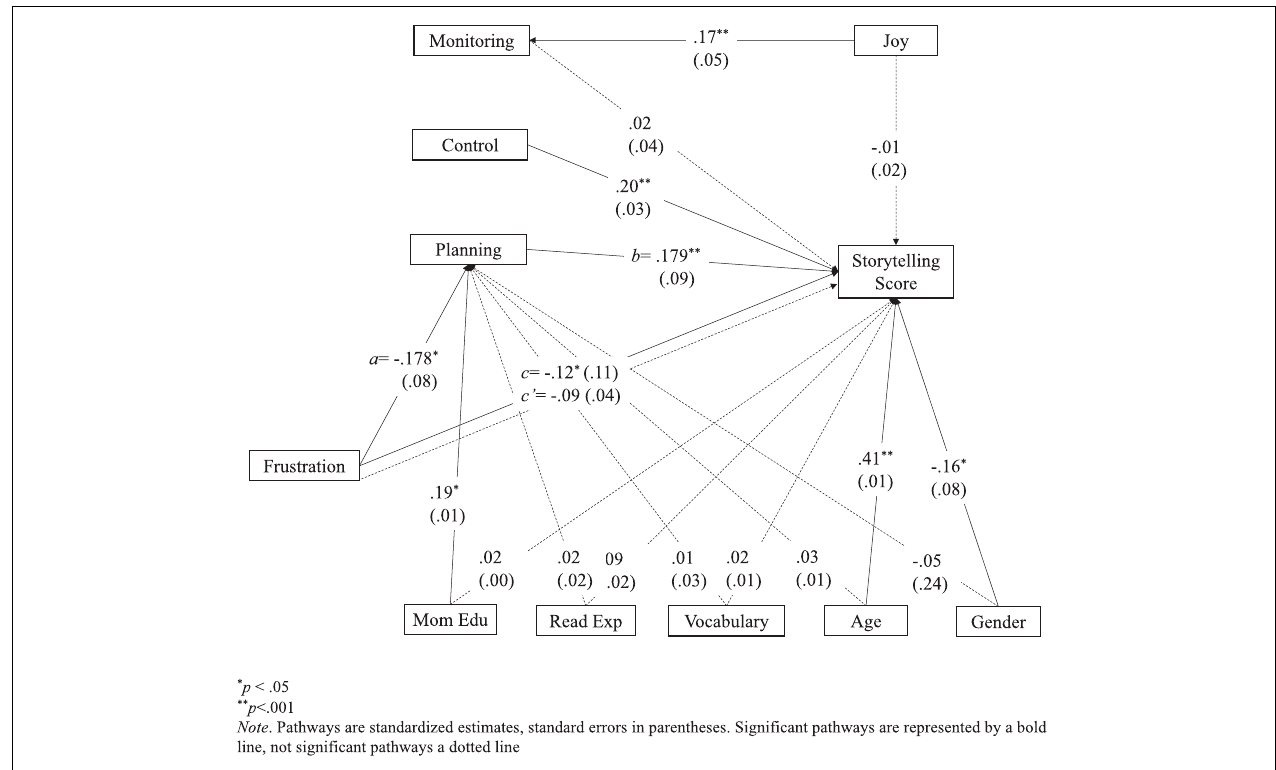
FIGURE 3 | Model with indirect mediated effects. Pathways are standardized estimates, standard errors in parentheses. Significant pathways are represented by a bold line, not significant pathways a dotted line. * p < 0.05, ** p <